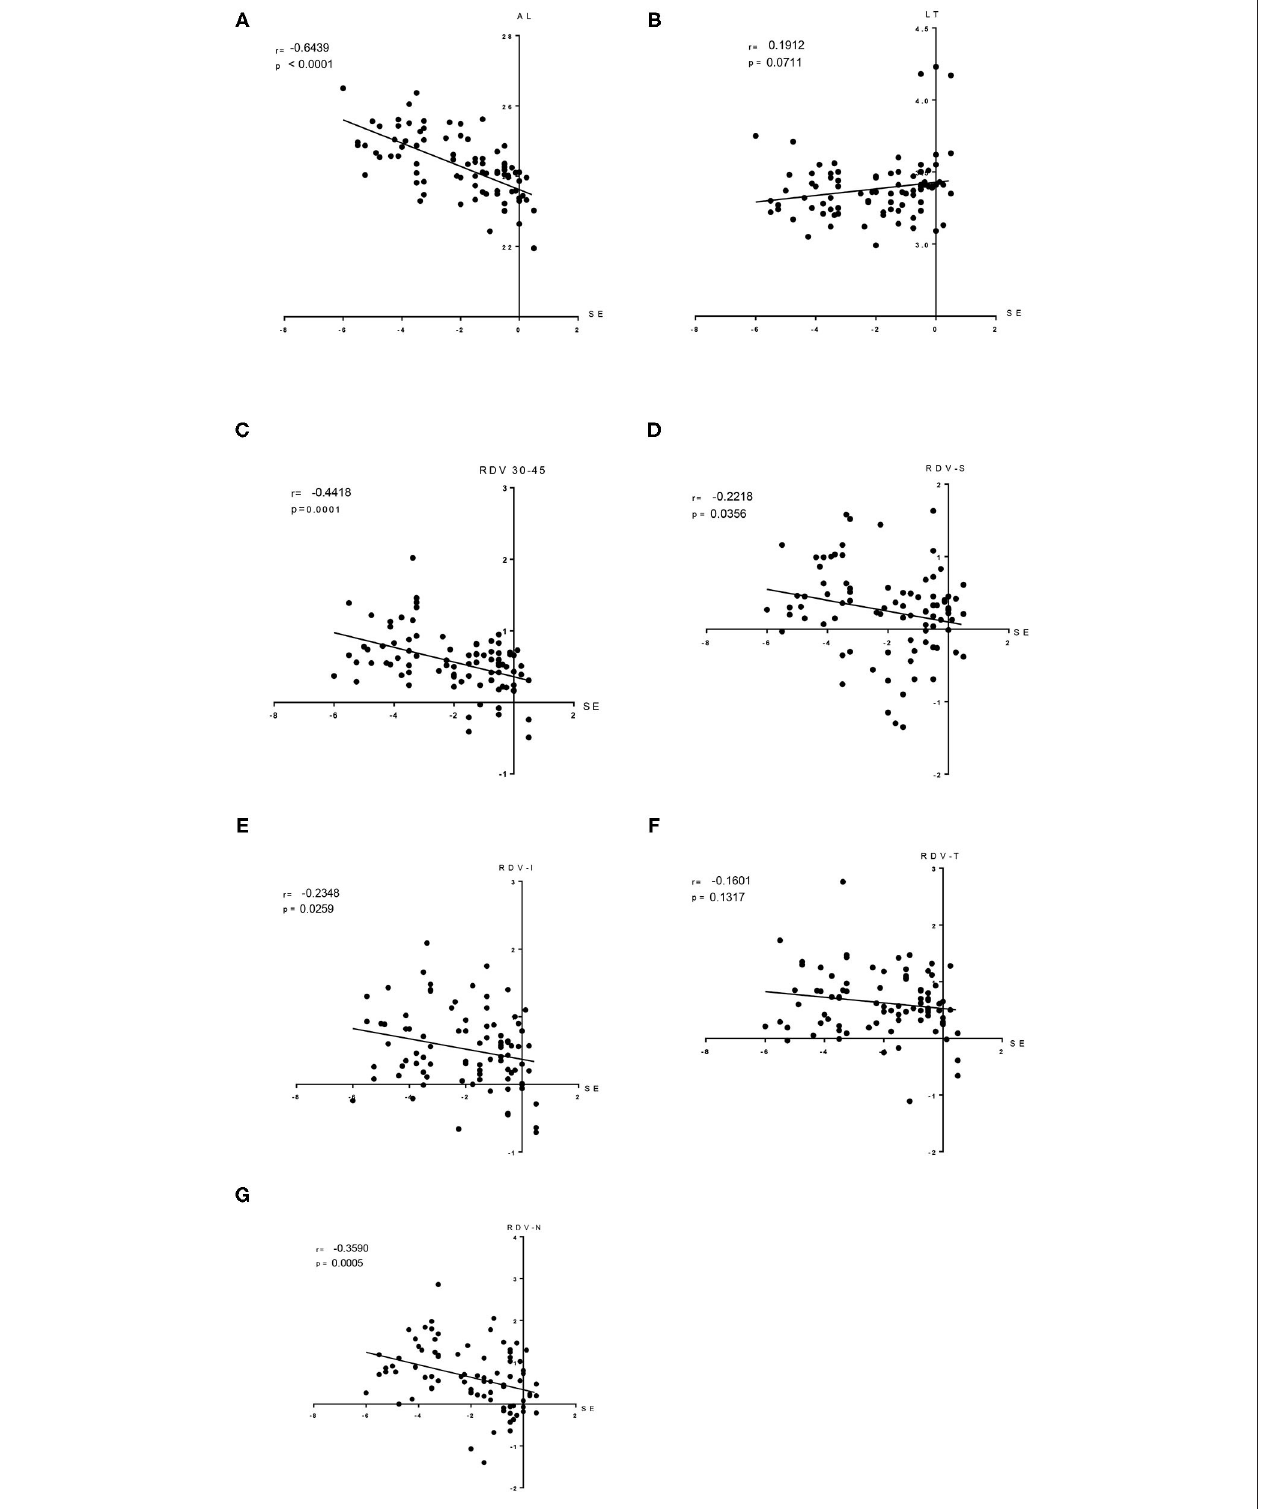
FIGURE 7 | Correlation analysis results. The SE negatively correlated with AL (A) ; the SE was positively correlated with LT (B) ; the SE was negatively correlated with RDV 30–45 (C) ; the SE was negatively correlated with RDV-S (D) ; the SE was negatively correlation with RDV-I (E) ; the SE was negatively correlated with RDV-T (F) ; and the SE was negatively correlation with RDV-N (G) . SE, spherical equivalent; and AL, Axial length.